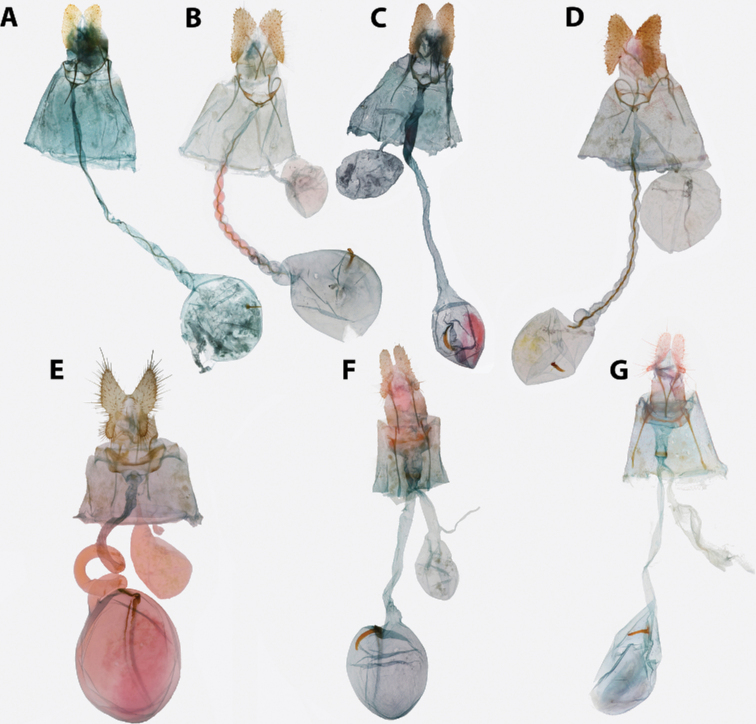
Clepsis and Mictopsichia group of genera female genitalia. Not to scale. ACle.
deroni sp. nov. holotype, Dominican Republic. KAA diss. #0058 (CMNH) BCle.
jamesstewarti sp. nov. holotype, Dominican Republic. KAA diss. #0149 (CMNH) CCle.
peroniae sp. nov. holotype, Dominican Republic. KAA diss. #0140 (USNM) DCle.
davisi sp. nov. holotype, Guadeloupe. KAA diss. #0183 (CUIC) EMictocommosis
lesleyae sp. nov. paratype, Dominican Republic. KAA diss. #0175 (CMNH) FMictopsichia
cubae, Dominican Republic. KAA diss. #0196 (CMNH) GMictopsichia
nyhllinda sp. nov. paratype, Dominican Republic. KAA diss. #0199 (CMNH).